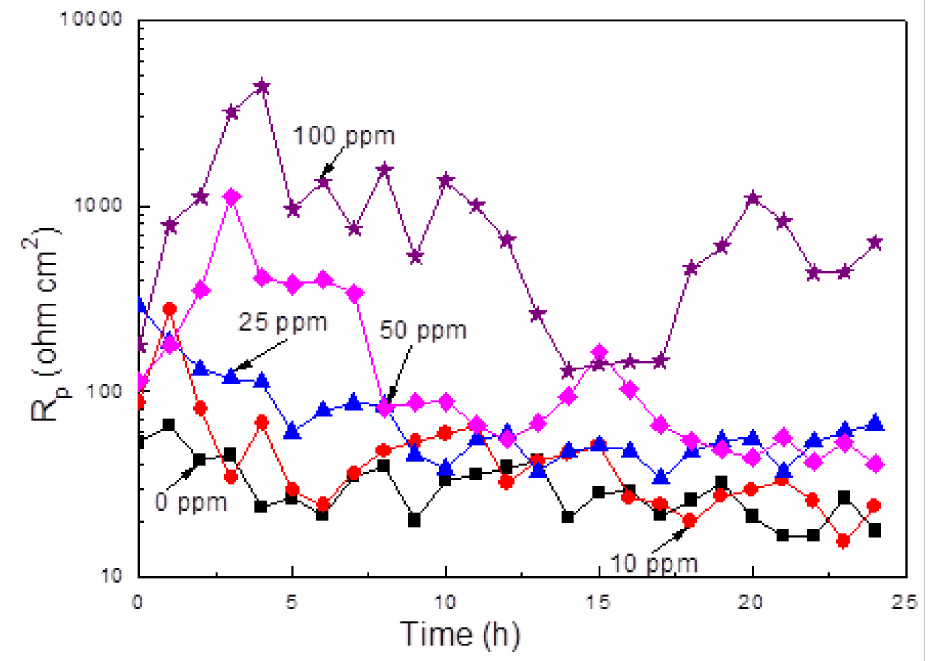
Figure 6. Variation on the R p value for X-120 steel in a CO 2 -saturated NaCl solution containing different concentrations of gemini